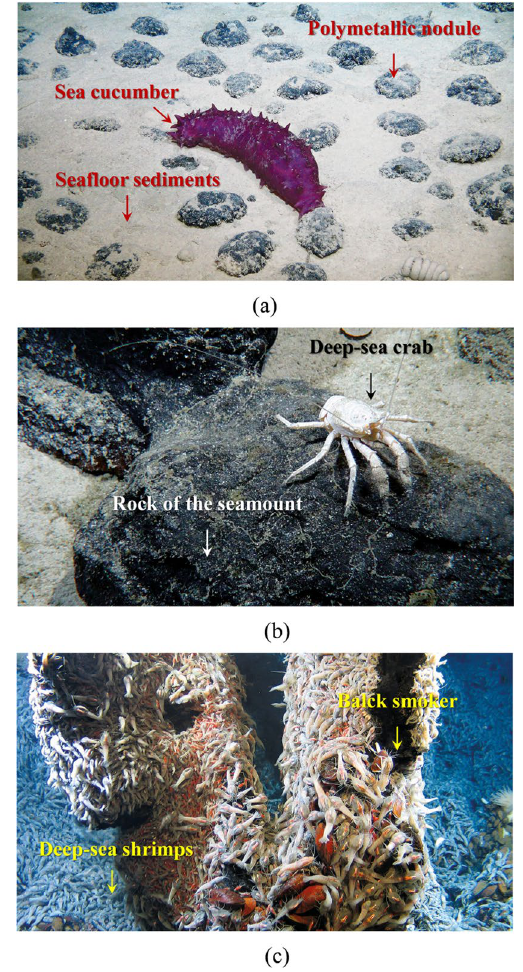
Fig. 22 Organisms living in areas where deep seabed mineral resources are found (photos taken by ROV KIEL 6000 during cruise M78/2) a Sea cucumber in a polymetallic nodule field b Deep-sea crab on a seamount c A dense population of deep-sea shrimps at a black